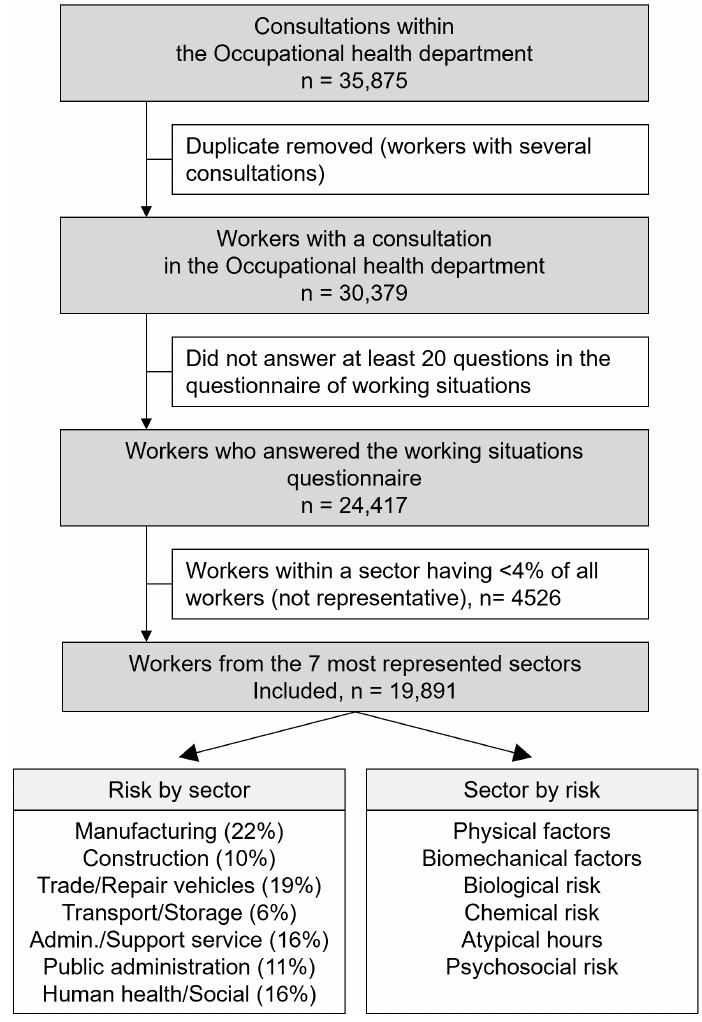
Figure 1. Flow chart of the data collection process.